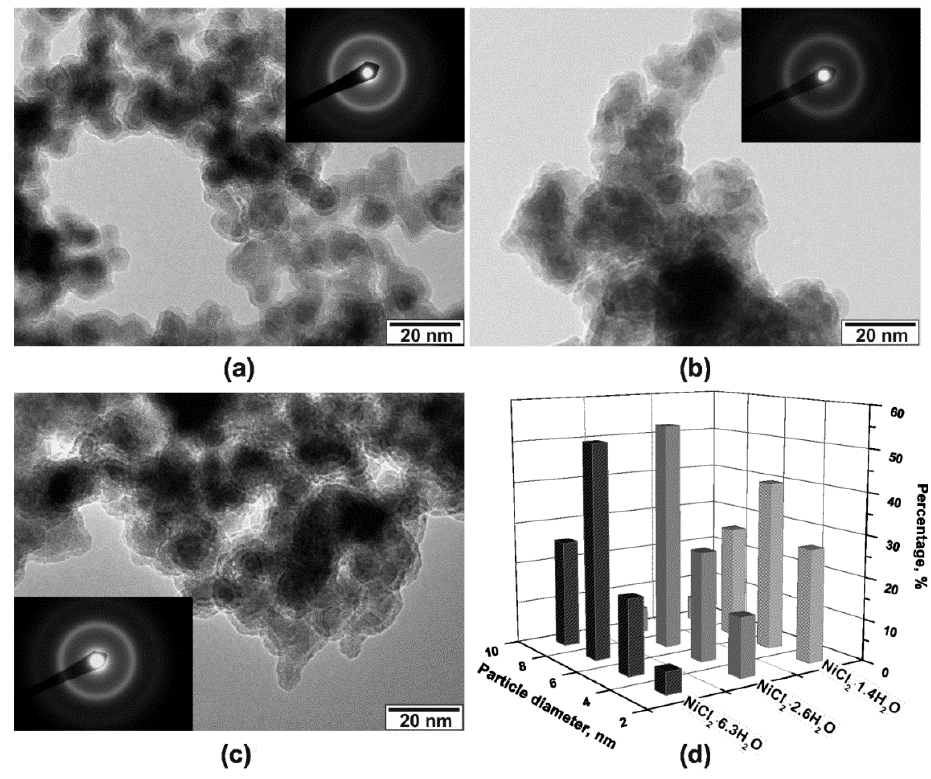
Figure 7. TEM images of nickel catalysts forming from ( a ) NiCl 2 · 6.3H 2 O, ( b ) NiCl 2 · 2.6H 2 O and ( c ) NiCl 2 · 1.4H 2 O, and ( d ) their particle size distribution.